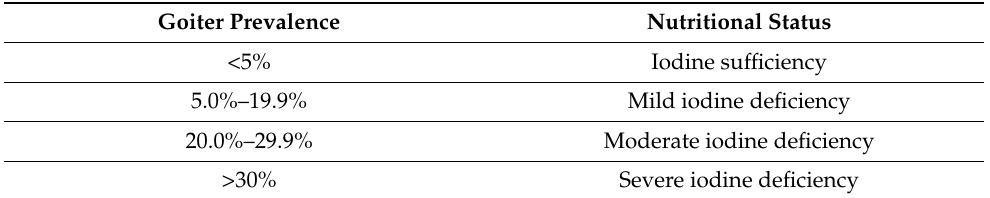
Table 3. Assessment of iodine intake in the general population based on goiter prevalence. Adapted from [16].